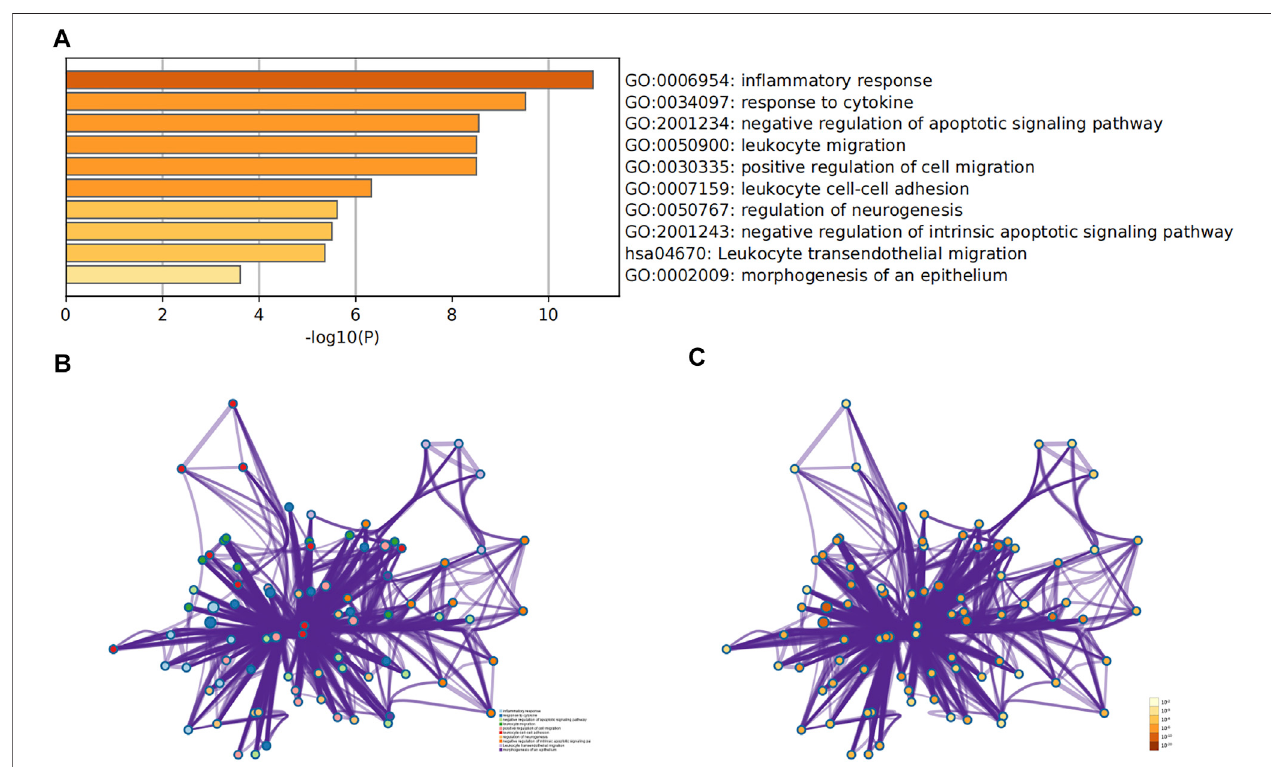
FIGURE 5 | Analysis of functional enrichment for hub genes. (A) Bar graph of GO analyses for hub genes. P-value is shown in color. Enrichment term network of hub genes; colors indicate the same cluster ID (B) , and P-value (C) .